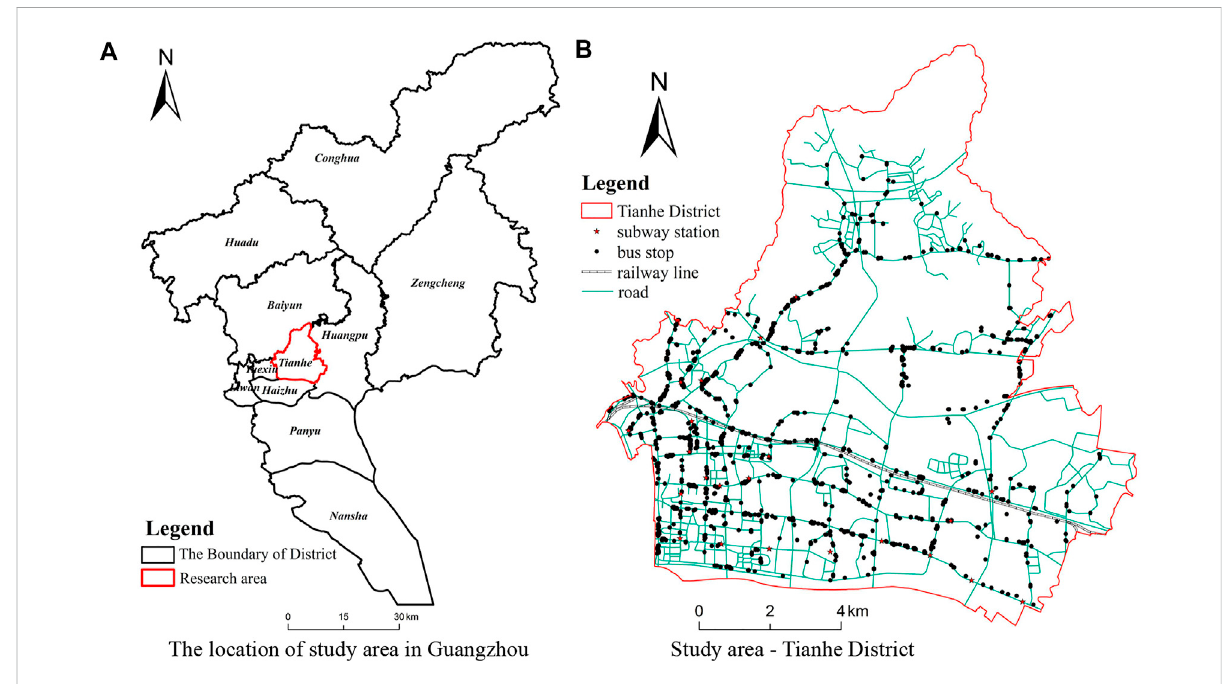
FIGURE 1 Study area-Tianhe District in Guangzhou. (A) Location of the study area in Guangzhou (B) Study area — Tianhe